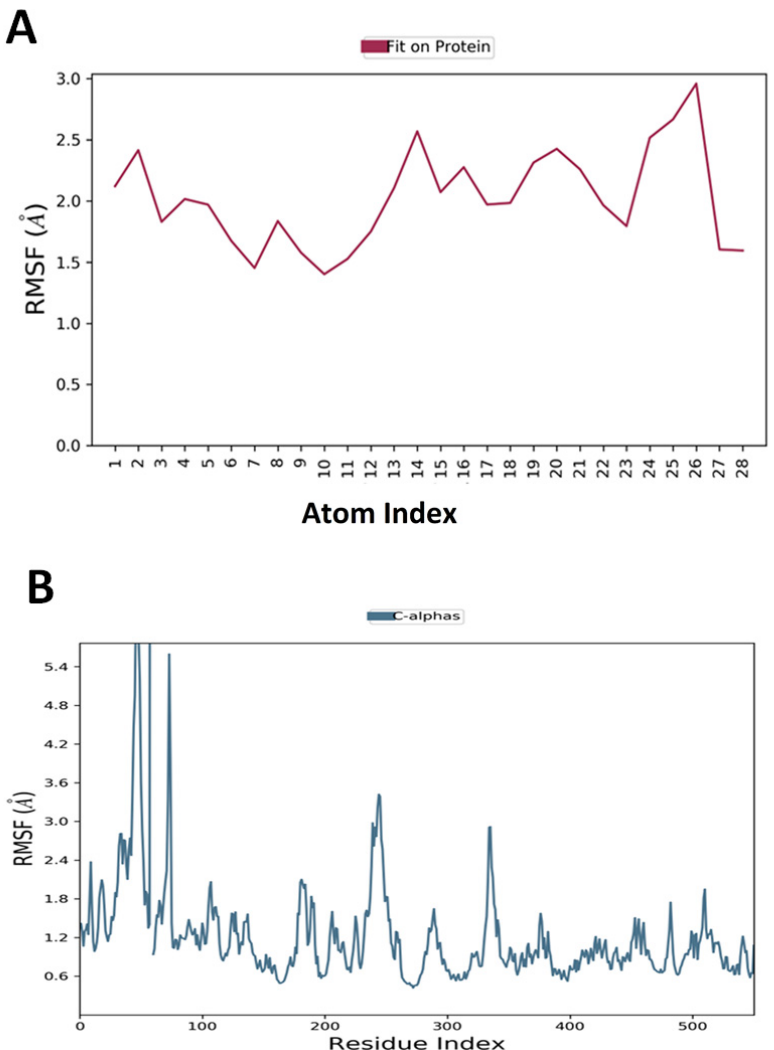
Figure 4. The root-mean-square fluctuation during the 100 ns timeframe of the MD simulation, the RMSF of the human COX2 receptor, and the complexed MAS-1696 ligand were measured. ( A ) The ligand RMSF. ( B ) The protein RMSF.